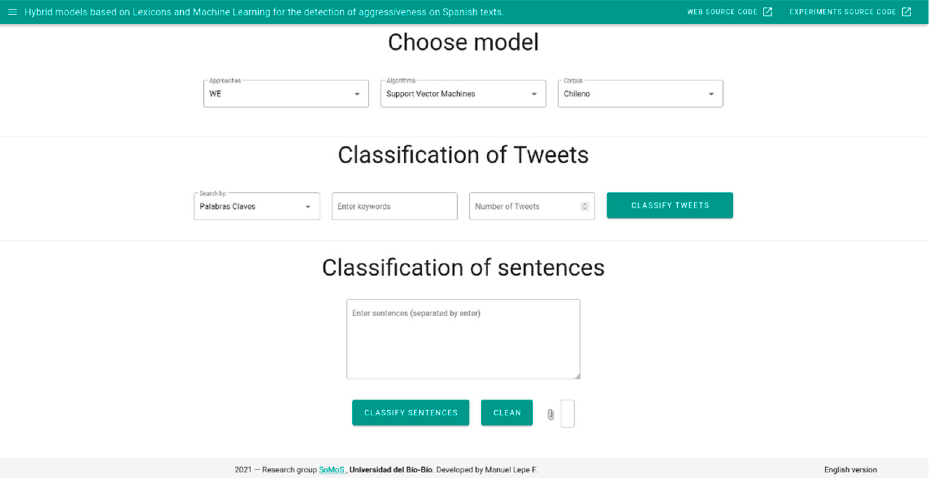
Figure 14. Web application.